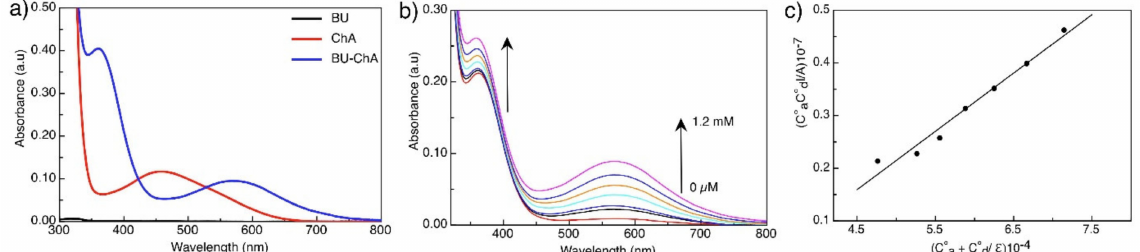
Figure 1. ( a ) absorption spectra of BU (0.05 mM), ChA (0.05 mM), and BUChA complex, ( b ) titration of BU (0.05 mM) and different concentration of ChA in methanol, ( c ) modified Benesi–Hildebrand plot for the BU and ChA titration in methanol.